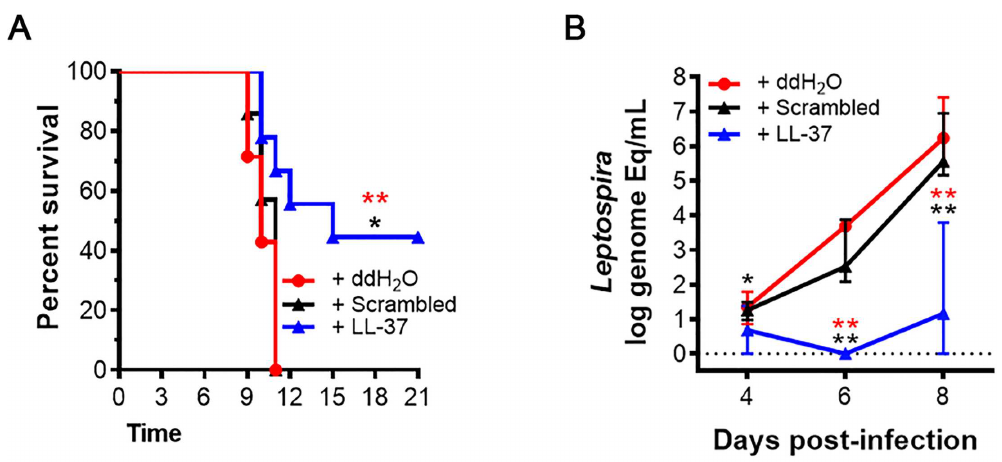
(Scrambled) (n = 7) ( P = 0.016) or ddH 2 O-treated controls (ddH 2 O) (n = 7) ( P = 0.008) followinglethal challenge with 100 Leptospira . (B) Bacterial loads ( Leptospira genomeequivalentsper mL of whole blood) in 7 infected hamsters were significantly lower at 4 ( P = 0.035; P = 0.146), 6 ( P = 0.003; P = 0.001), and 8 days ( P = 0.003; P = 0.001) post-infection in LL-37-treated hamsters relative to 7 scrambledpeptide (black) or ddH 2 O-treated controls (red), respectively. Shown are medians ± IQR. An * signifiesa P -value (cid:20) 0.05; ** signifies P < 0.01 as determinedby Mantel Cox test for ( A ) or Mann-Whitney test for ( B